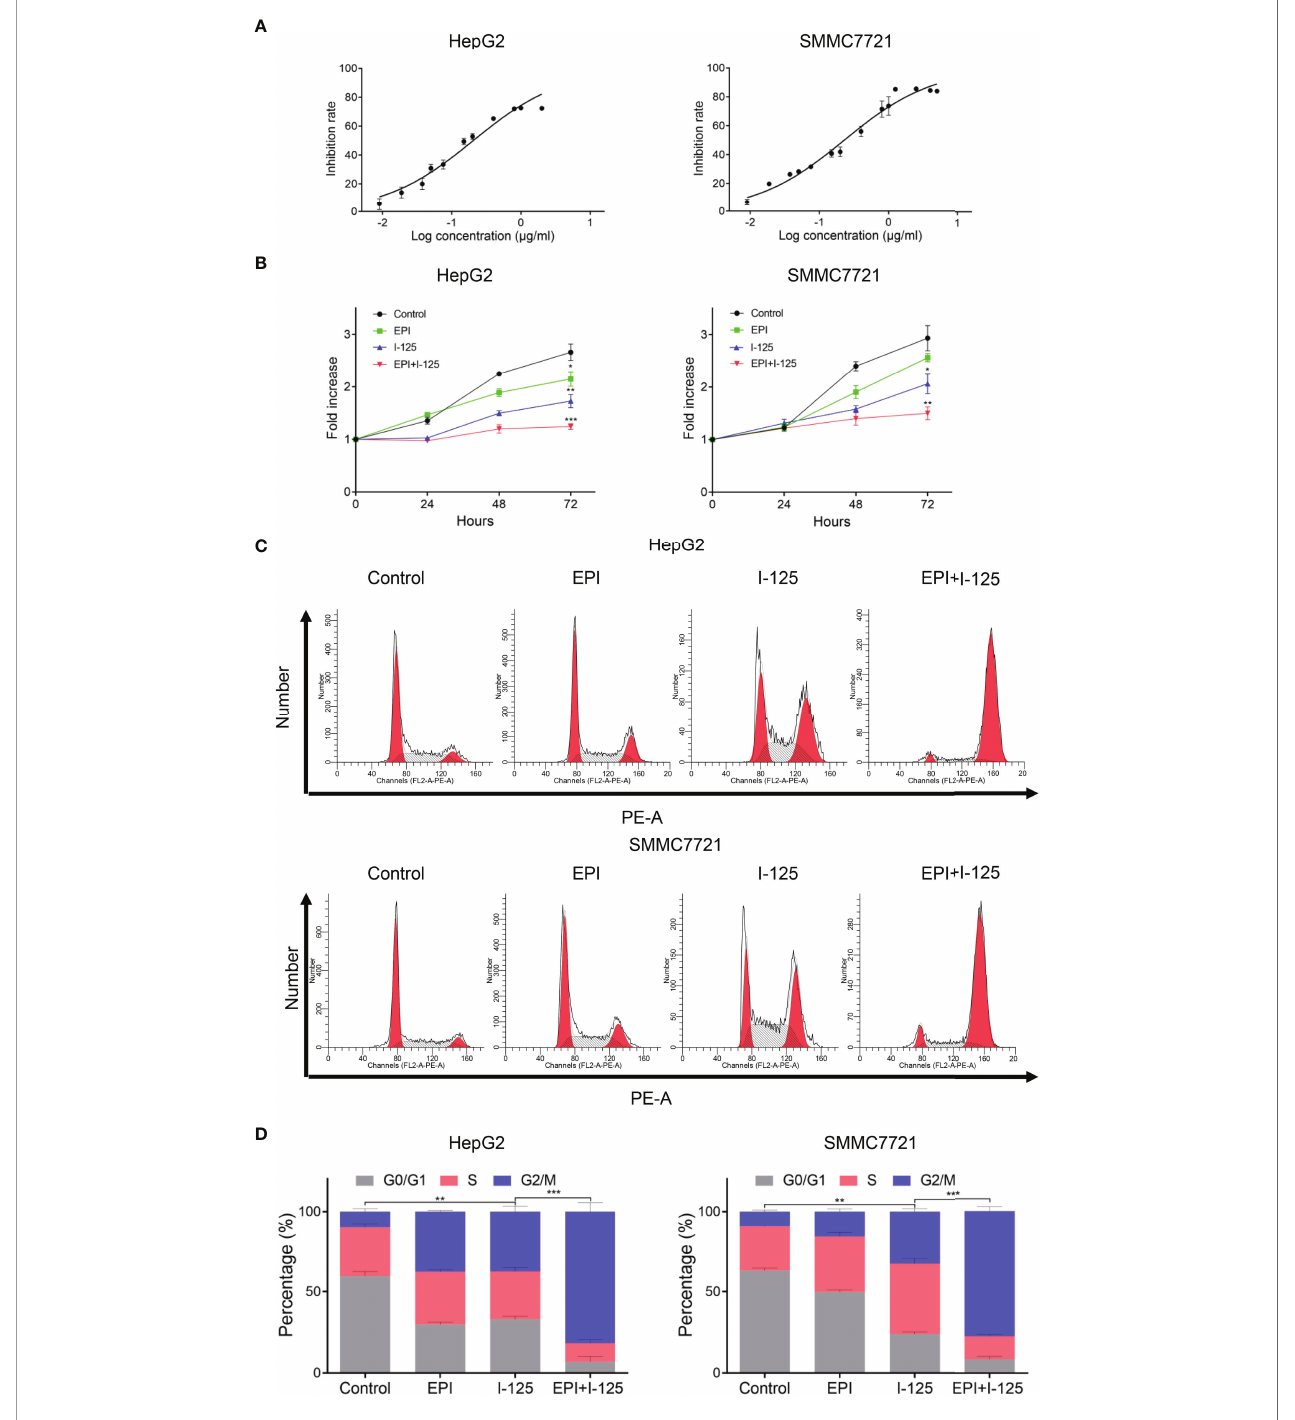
FIGURE 1 | EPI enhances the 125 I-induced anti-proliferation effect in HCC cells. (A) Inhibition rate of EPI on HCC cells. (B) CCK-8 assay quantifying HCC cell proliferation after EPI and 125 I treatment, alone or in combination. (C, D) Cell cycle analysis after EPI and 125 I treatment, alone or in combination. All experiments were performed in triplicate, and the data are presented as the mean ± SD. * P < 0.05, ** P < 0.01, *** P < 0.001. HCC, hepatocellular carcinoma cells; EPI, epirubicin; CCK-8, cell counting